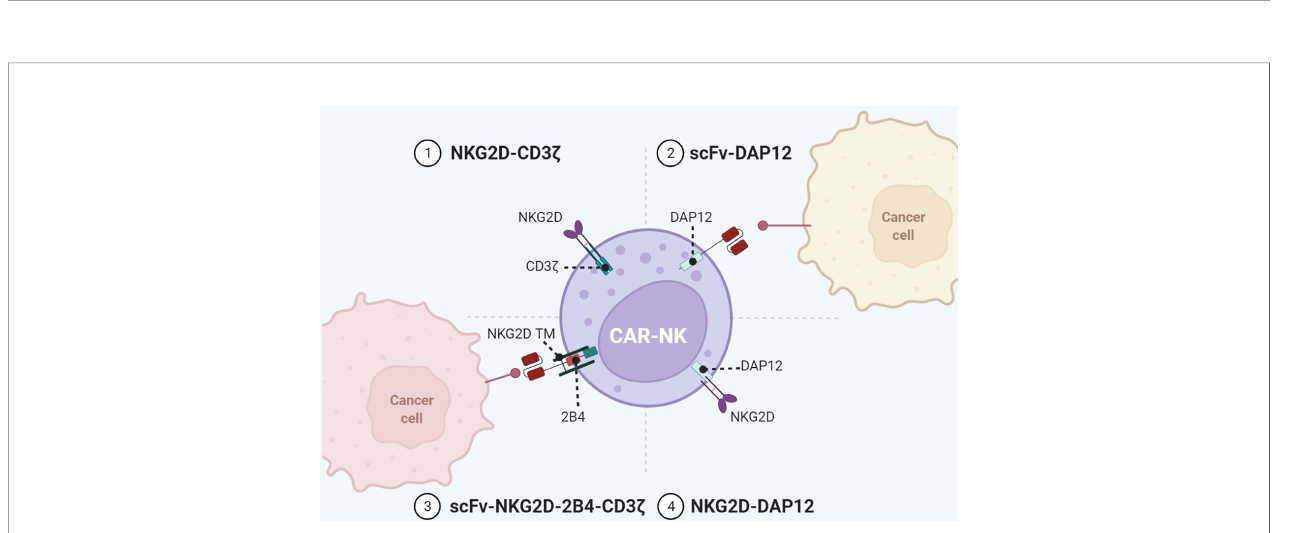
FIGURE 4 | Representative designs of CARs with NK cell-associated repertoires. Diagrams of CAR-NK using NKG2D or DAP12 for immune activity. Co-expression of NK cell-associated receptors/adaptors such as NKG2D, KIR, TREM, DAP12, and 2B4 in the con fi guration of CARs enables a wider range of targets and enhanced antitumor immunity. Figure created using